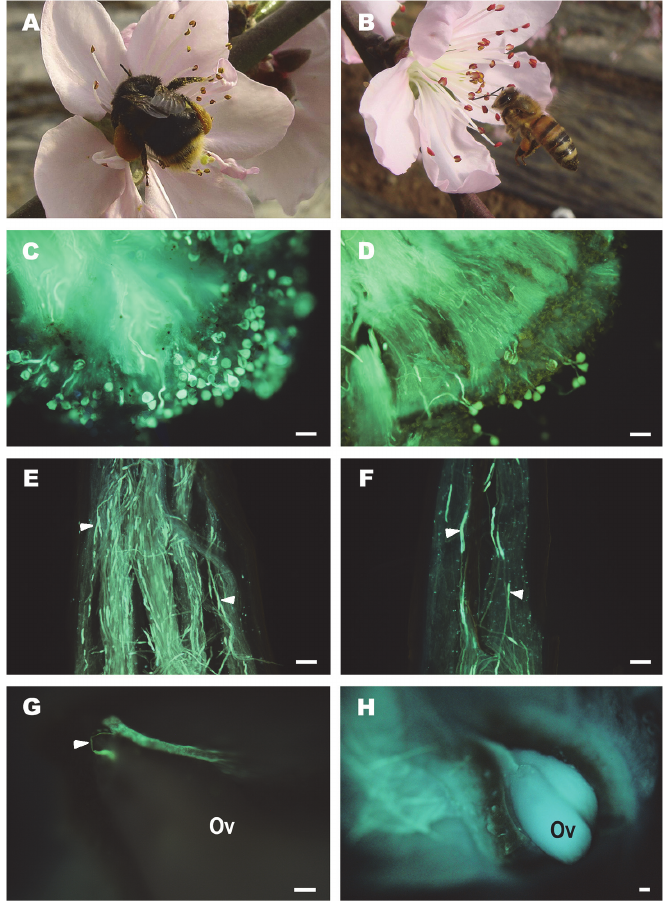
Pollen grain germination on peach stigma of flower pollinated by (C) B . patagiatus and (D) A . mellifera . Pollen tubes (white arrowheads) growth in style of peach flower pollinated by (E) B . patagiatus and (F) A . mellifera . (G) pollen tube (white arrowhead) penetrating ovule of peach flower 7 days after pollination by B . patagiatus . (H) ovule of peach flower 7 days after pollination by A . mellifera . All scale bars = 50 μ